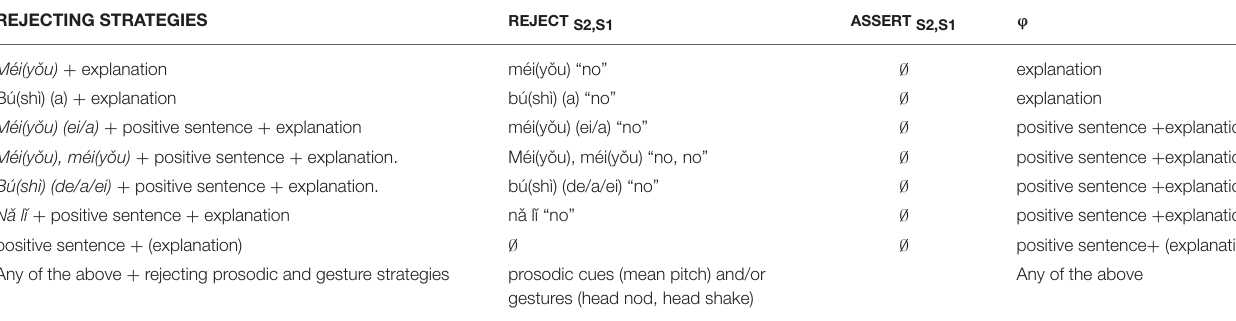
TABLE 3 | Speech act analysis of rejecting strategies in MC. REJECTING STRATEGIES REJECT